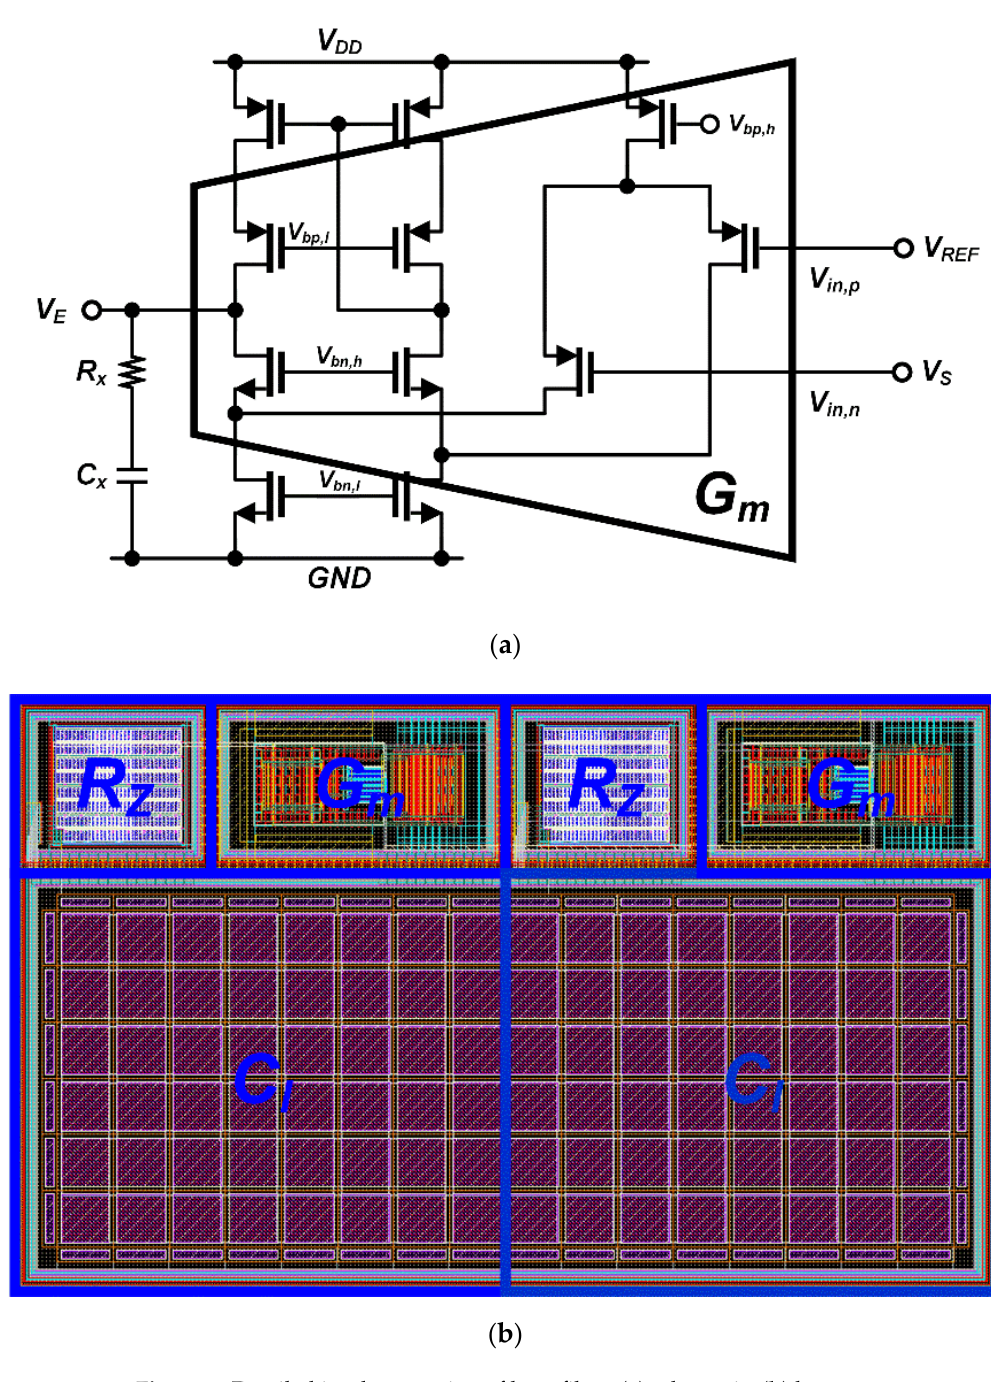
Figure 8. Detailed implementation of loop filter: ( a ) schematic; ( b ) layout.